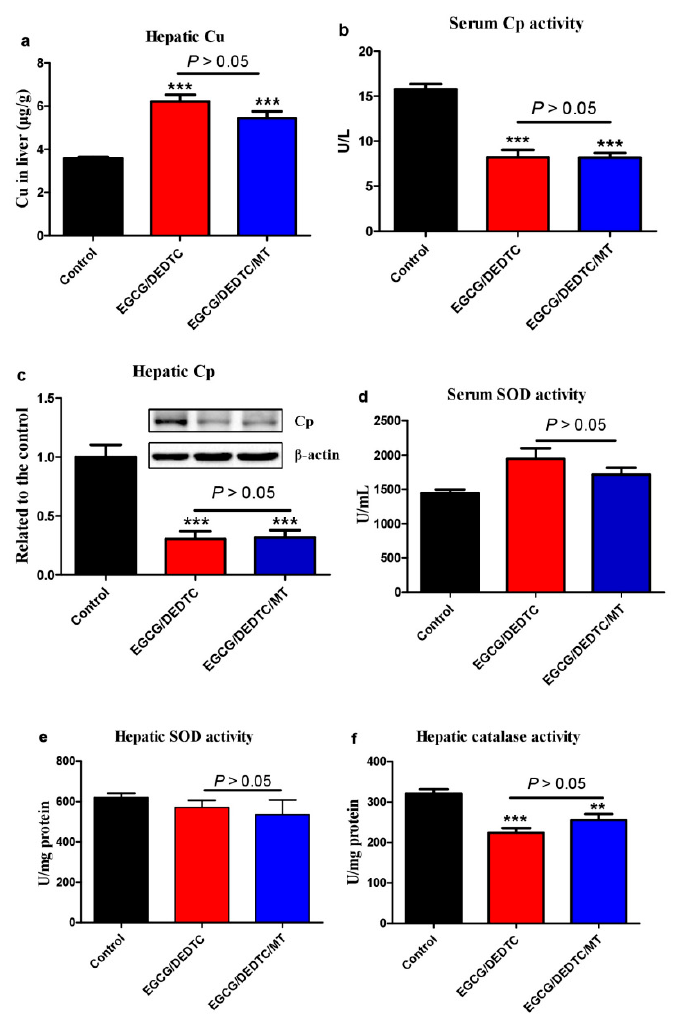
Figure 10. Copper status and antioxidant enzymes responsible for controlling EGCG oxidation in mice. Experimental conditions were the same as Figure 9. ( a ) Hepatic copper levels. ( b ) Serum ceruloplasmin (Cp) activity. ( c ) Hepatic Cp levels. ( d ) Serum SOD activity. ( e ) Hepatic SOD activity. ( f ) Hepatic catalase activity. Data are presented as mean ± SEM (n = 6). Compared to the control, ** P < 0.01 and *** P < 0.001. The hepatic Cu level ( a ) was analyzed by one-way ANOVA post hoc Dunnett test and the other data ( b – f ) were analyzed by one-way ANOVA post hoc Tukey’s test.